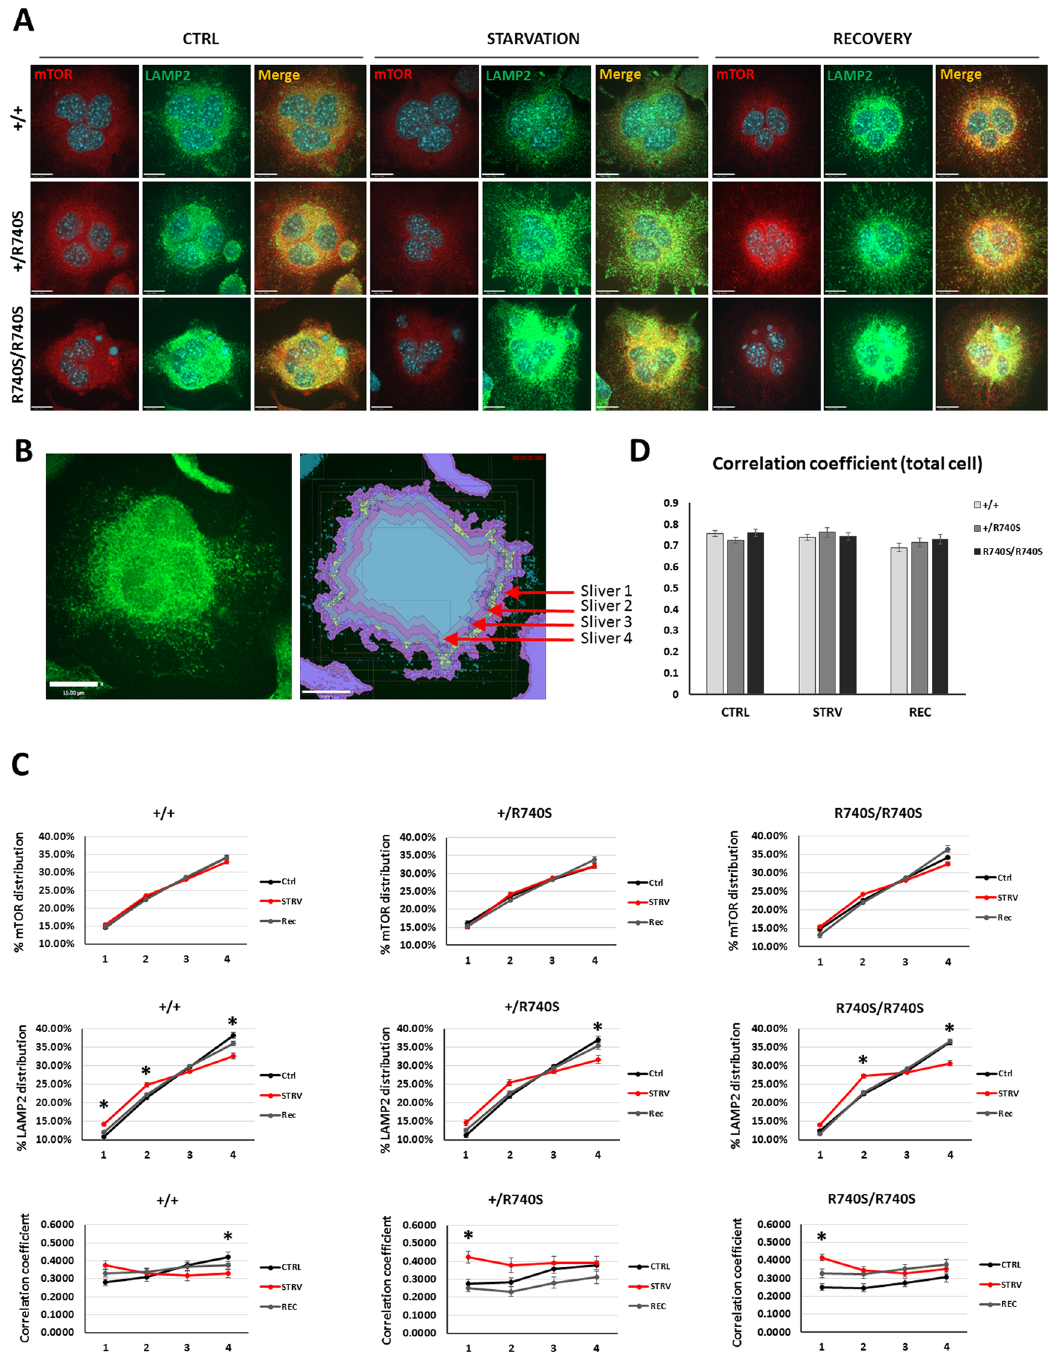
Figure 3. mTOR/LAMP2 co-localization in osteoclasts does not change in response to amino acid availability. Spleen-derived osteoclasts were differentiated as described in “Materials and Methods”. On day 4 of culture, the cells were incubated with HBSS (starvation) for 60 min and then with fully supplemented media for 30 min. ( A ) Cells were fixed and stained using anti-mTOR and anti-LAMP2 antibodies. Representative confocal images; nuclei were stained with DAPI; bars 15 µ m. ( B ) Custom macro peripheral depth analysis mask showing depth/ sliver distribution. ( C ) Quantification of mTOR and LAMP2 distribution, mTOR/LAMP2 co-localization at the periphery, Pearson’s correlation coefficient; mean ± SEM, * indicates statistical significance compared to + / + control, p < 0.05. ( D ) Total cell Pearson’s correlation coefficient; mean ± SEM. The number of cells used for quantification is as follows: + / + CTRL n = 38; + / + STRV n = 39; + / + REC n = 47; + /R740S CTRL n = 33; + /R740S STRV n = 27; + /R740S REC n = 34; R740S/R740S CTRL n = 44; R740S/R740S STRV n = 43; R740S/ R740S REC n =